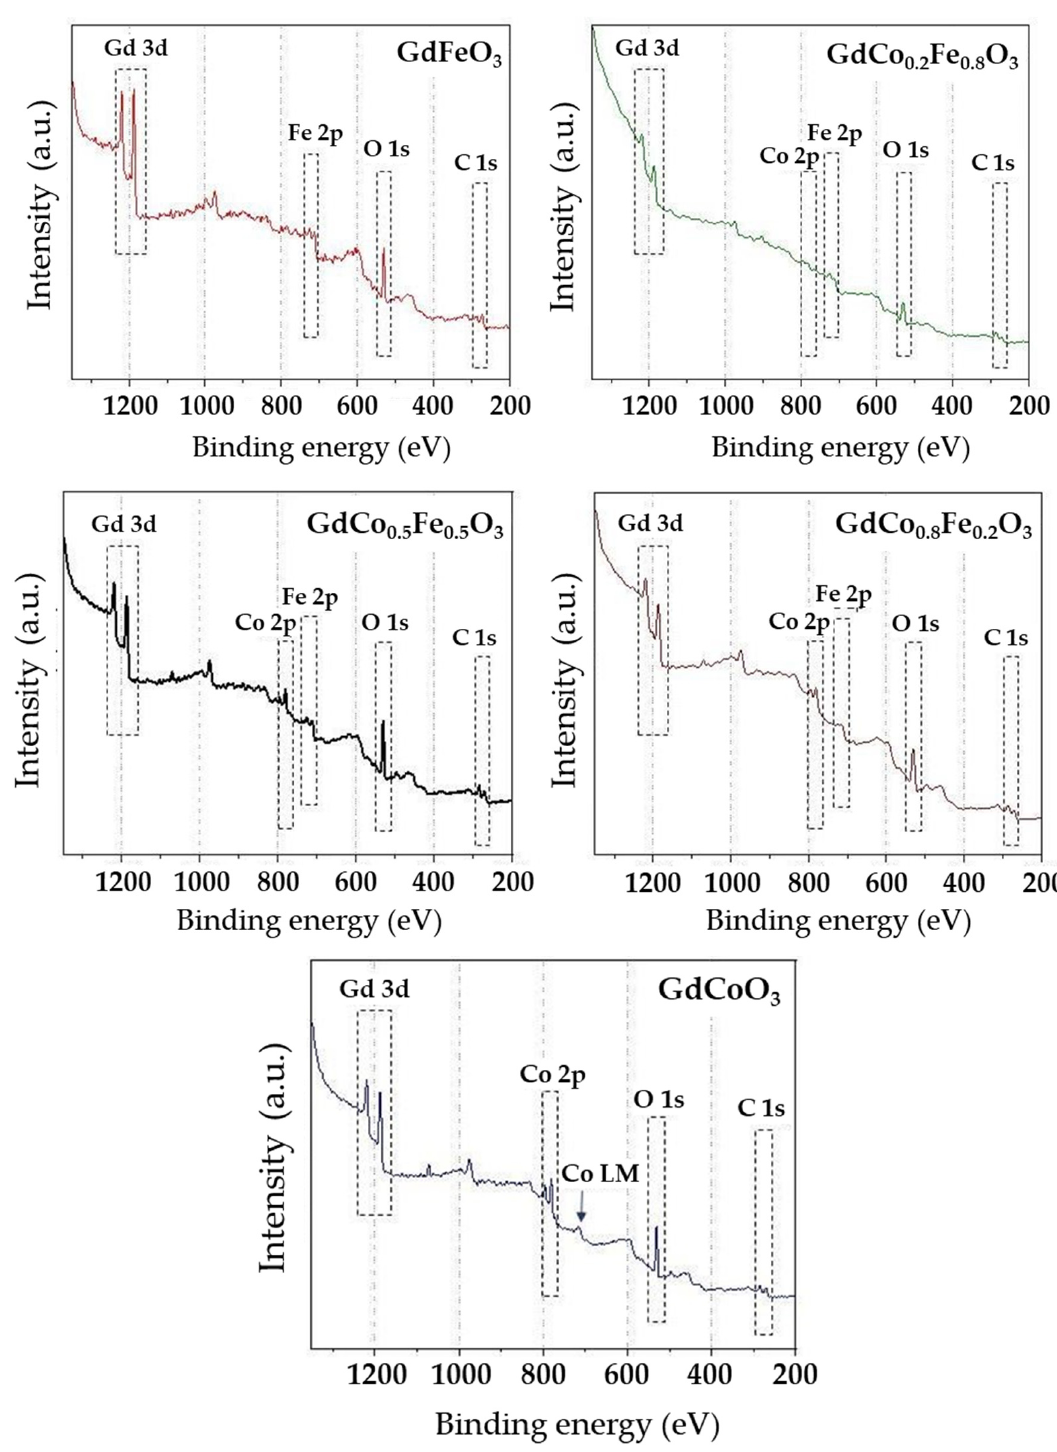
Figure 3. Survey XPS spectrum for compounds in the composition GdCo x Fe 1 − x O 3 (x = 0; 0.2; 0.5; 0.8; 1) and identification of the main photoelectron lines.